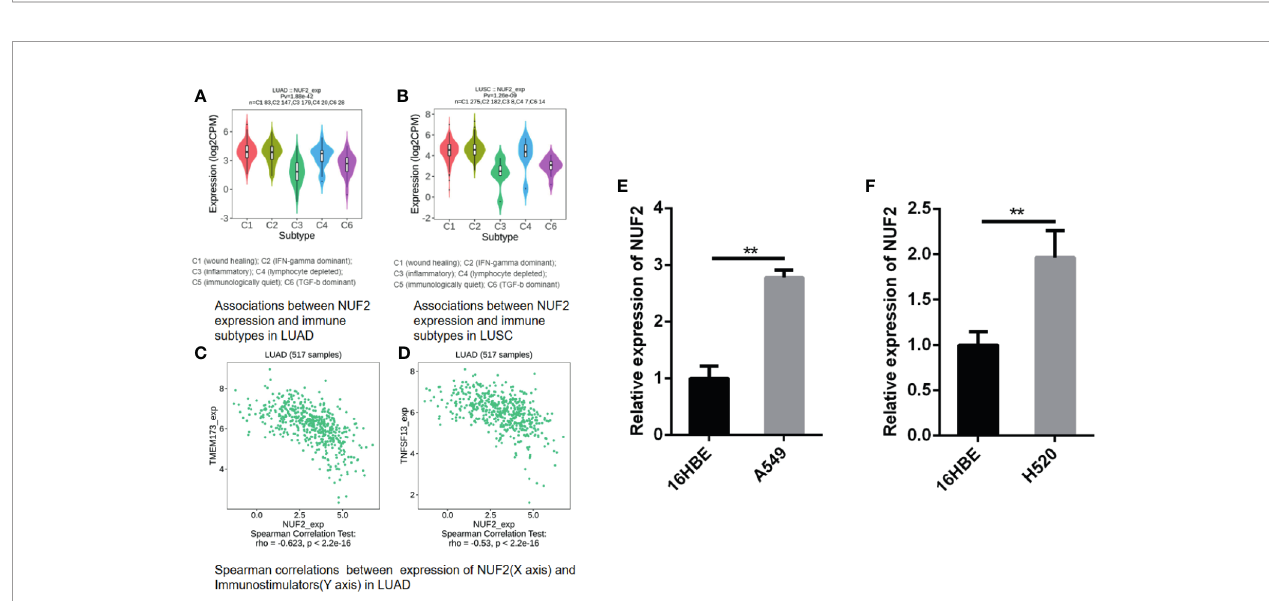
FIGURE 10 | (A, B) Associations between NUF2 expression and immune subtypes in LUAD and LUSC. (C, D) Associations between NUF2 expression and immune subtypes in LUAD. (E) NUF2 expression was signi fi cantly higher in human lung adenocarcinoma cell line (A549) than in normal bronchial epithelial cells. (F) NUF2 expression was also signi fi cantly higher in human lung squamous cell line (H520) than in normal bronchial epithelial cells. **p <